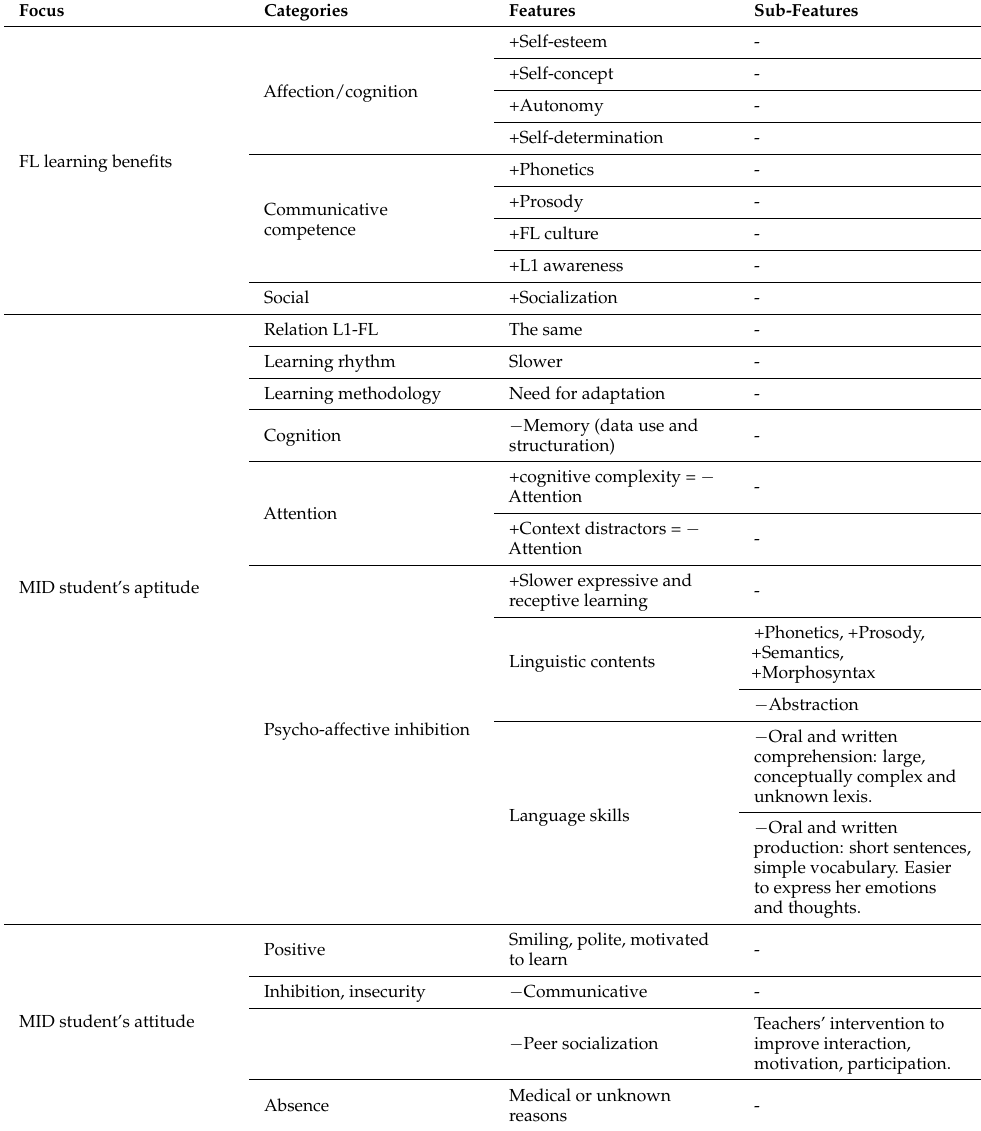
Table 3. Summary of stakeholders’ perspectives on the teaching of the FL to the MID